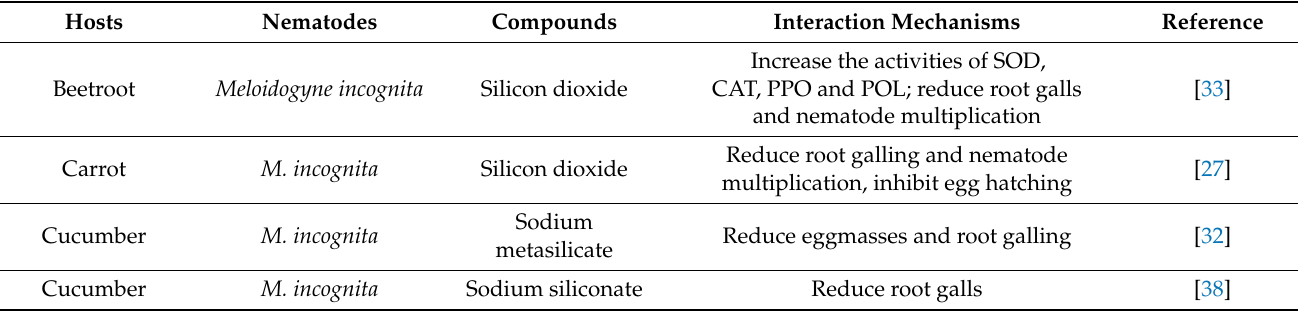
Table 1. Effect of silicon on plant nematode management and related interaction mechanisms